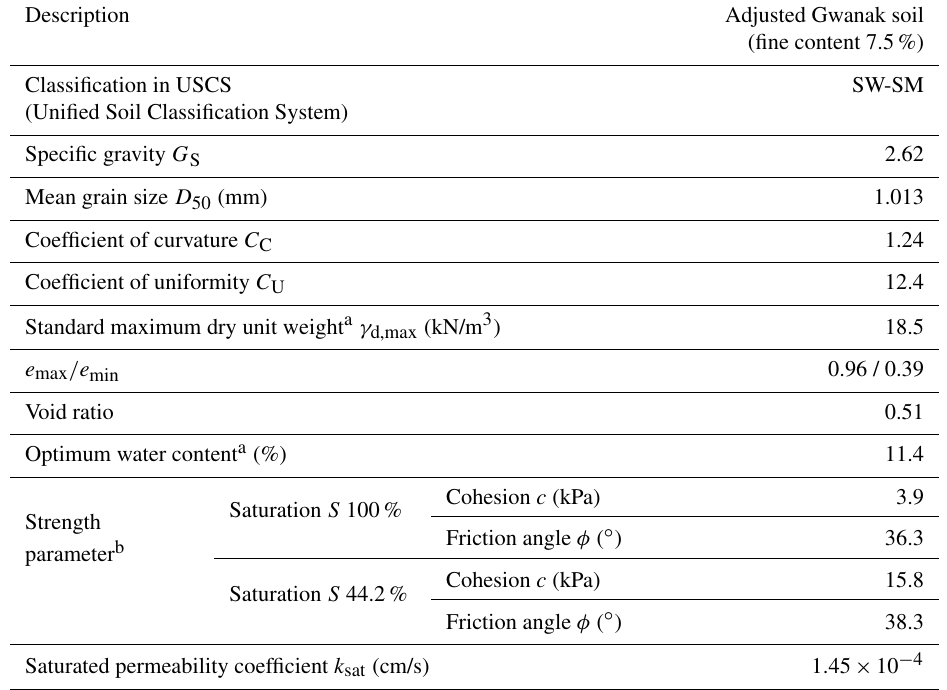
Table 2. Properties of adjusted Gwanak soil.